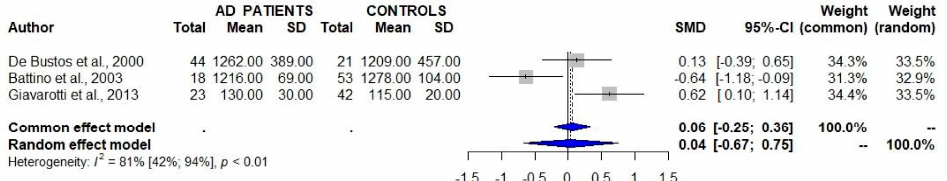
Figure 2. Studies assessing the serum/plasma levels of CoQ 10 in patients with Alzheimer’s disease (AD) and controls show a lack of significant differences between the two groups. 95% CI 95% con- fidence intervals; SMD standard mean difference [8–10].